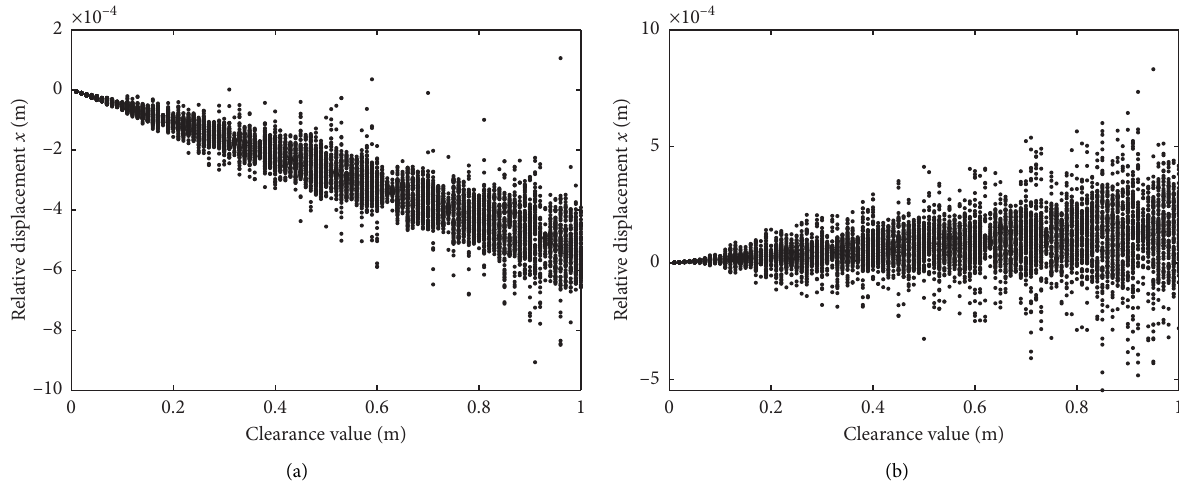
Figure 26: Variable clearance bifurcation diagram of the seven-bar hybrid drive at (a) clearance A and (b) clearance